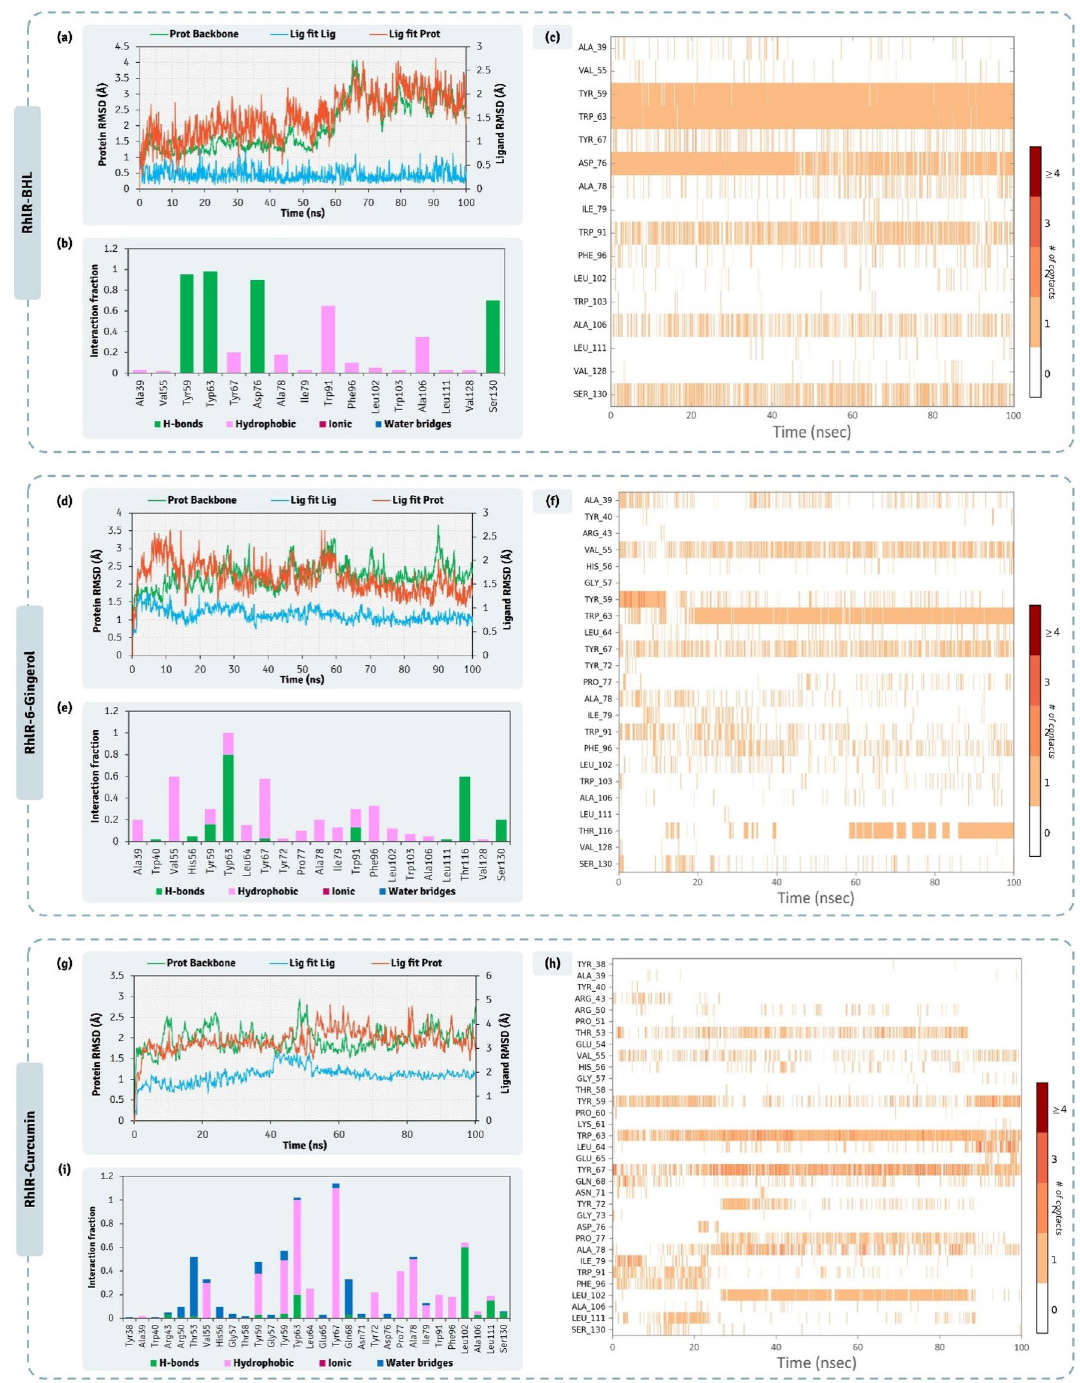
Figure 10. 100 ns MD simulation trajectory representing the RMSD assessment, ligand-receptor interaction profile and ligand-receptor interaction timeline for RhlR-HHL, RhlR-6-Gingerol, and RhlR-Curcumin